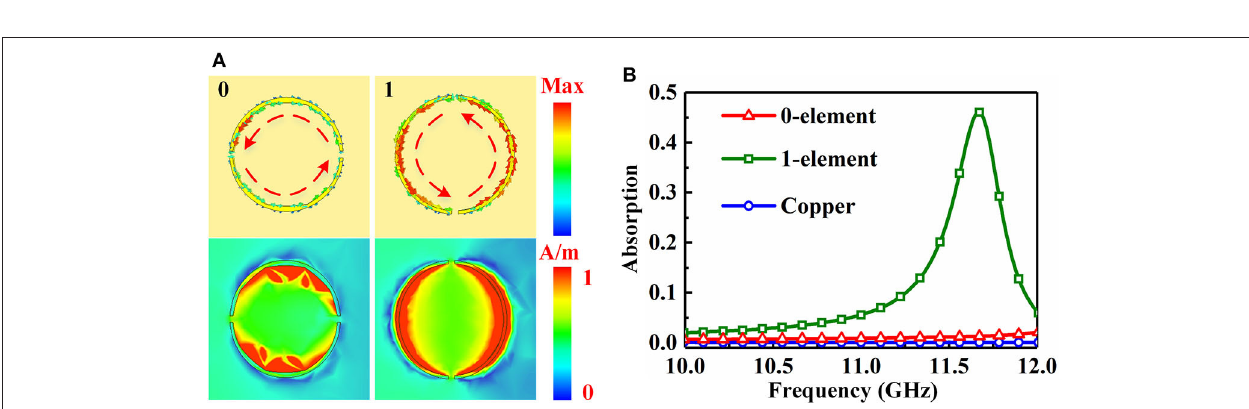
FIGURE 3 | The coding elements used to regulate the amplitude and phase. (A) Top view of the coding elements numbered 0-element and 1-element. (B) The amplitudes of reflection coefficient of two coding elements. (C) The phases and phase difference of two elements.